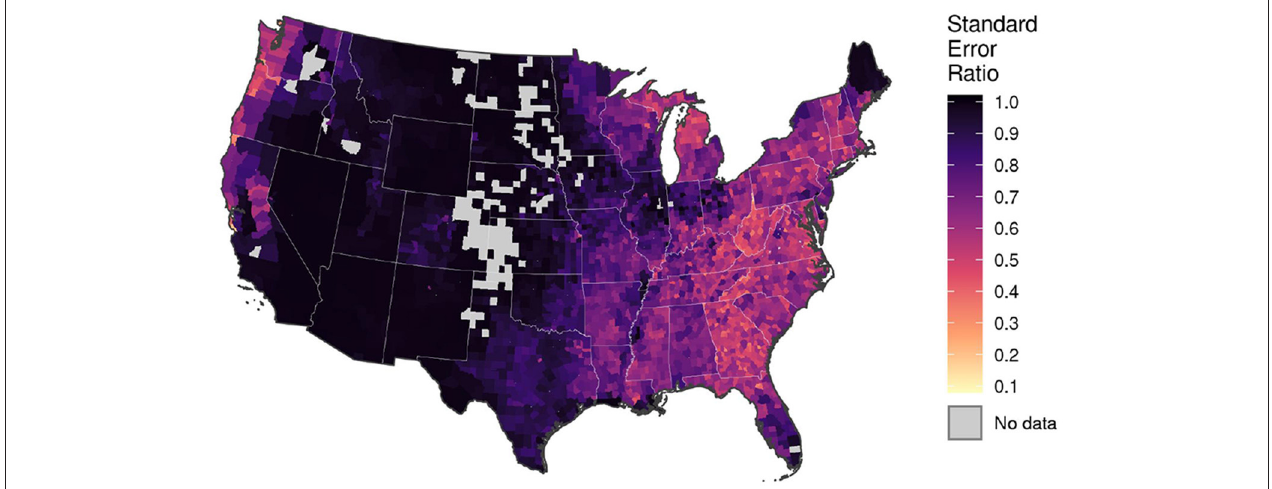
FIGURE 4 | County-level ratios of the standard error of the spatial Fay-Herriot model-based estimator of mean forest carbon density, relative to that of the post-stratified estimator. Ratios < 1 indicate the model-based approach yields a more precise estimator of forest carbon stocks than the traditional design-based approach. Gray shaded counties indicate no forested FIA plots were encountered in the county during the most recent current volume inventory, i.e., direct estimator of total forest carbon and associated variance for the county are equal to zero.